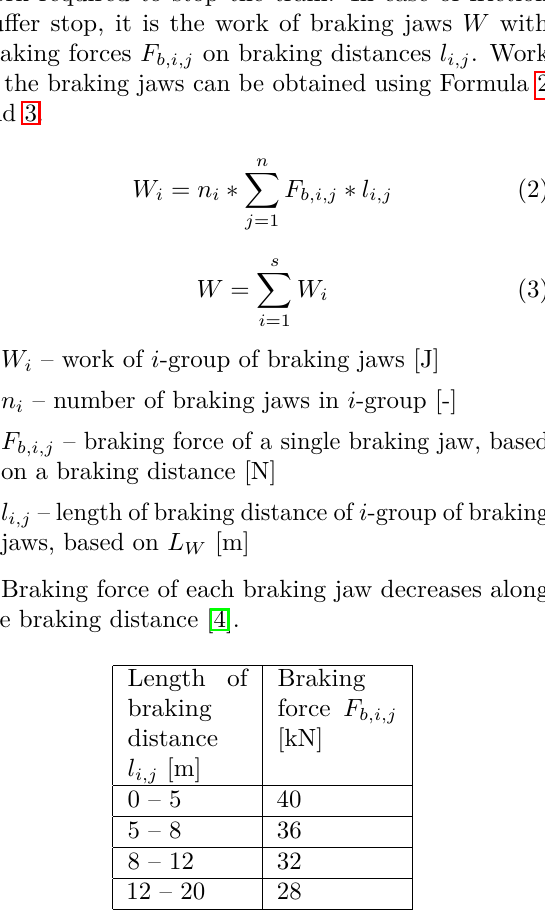
Table 3. Braking force of a braking jaw along the braking distance